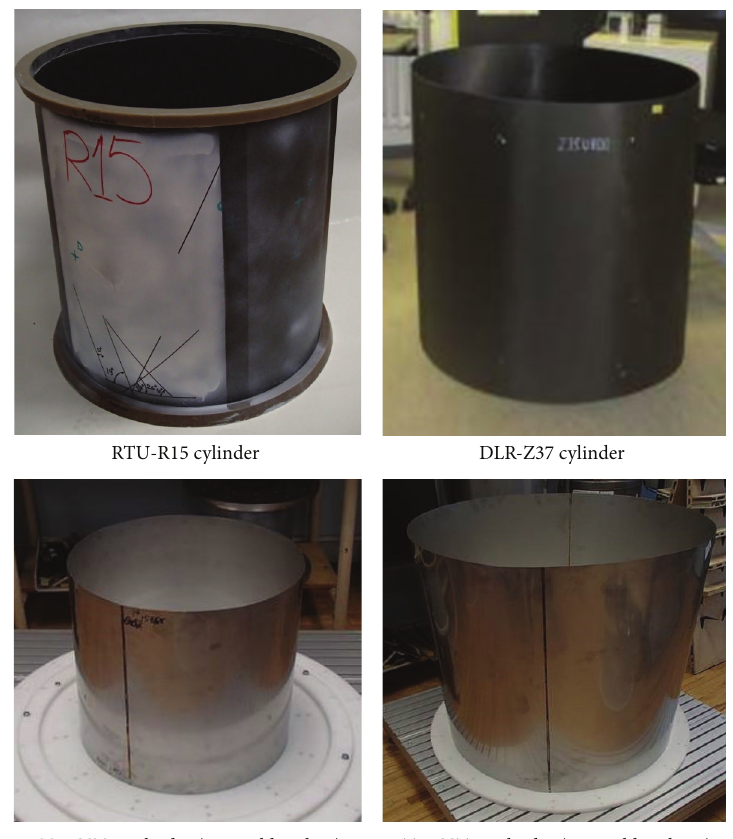
Figure 1: Overview of tested cylindrical shells.